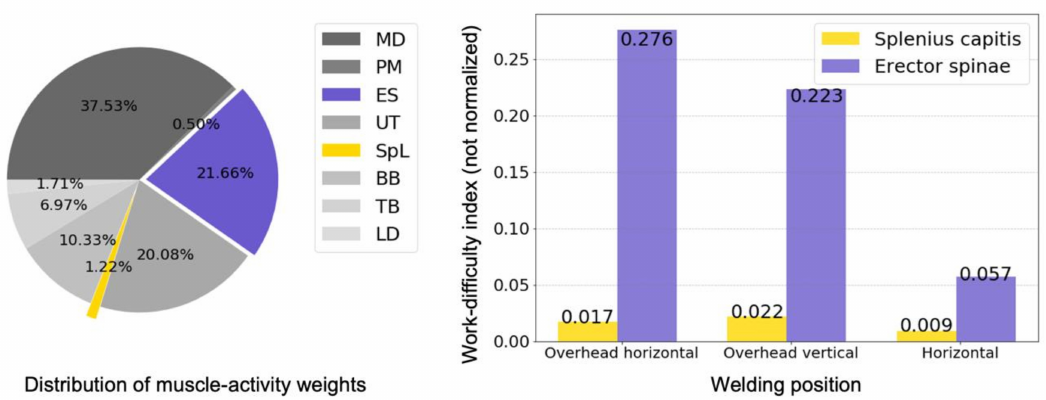
Figure 11. Muscle-activity weights (left) and work-difficulty indexes for three positions